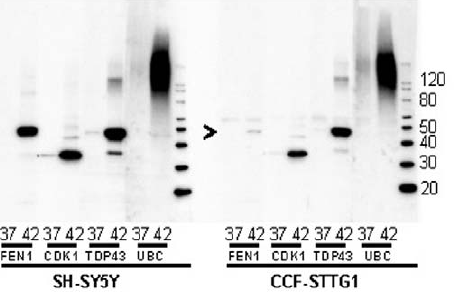
Figure 4. Immunoblot validation of LC-MS/MS data. Cells from each cell line were either held at 37 u C or heat-shocked at 42 u C and then lysed and fractionated as described in Methods. Equal amounts, by volume, of DOC-P fraction from control and heat-shocked cells were probed with antibodies to FEN1, CDK1, TDP-43, and Ubiquitin. The image shown is representative of 3 independent replications of the experiment.